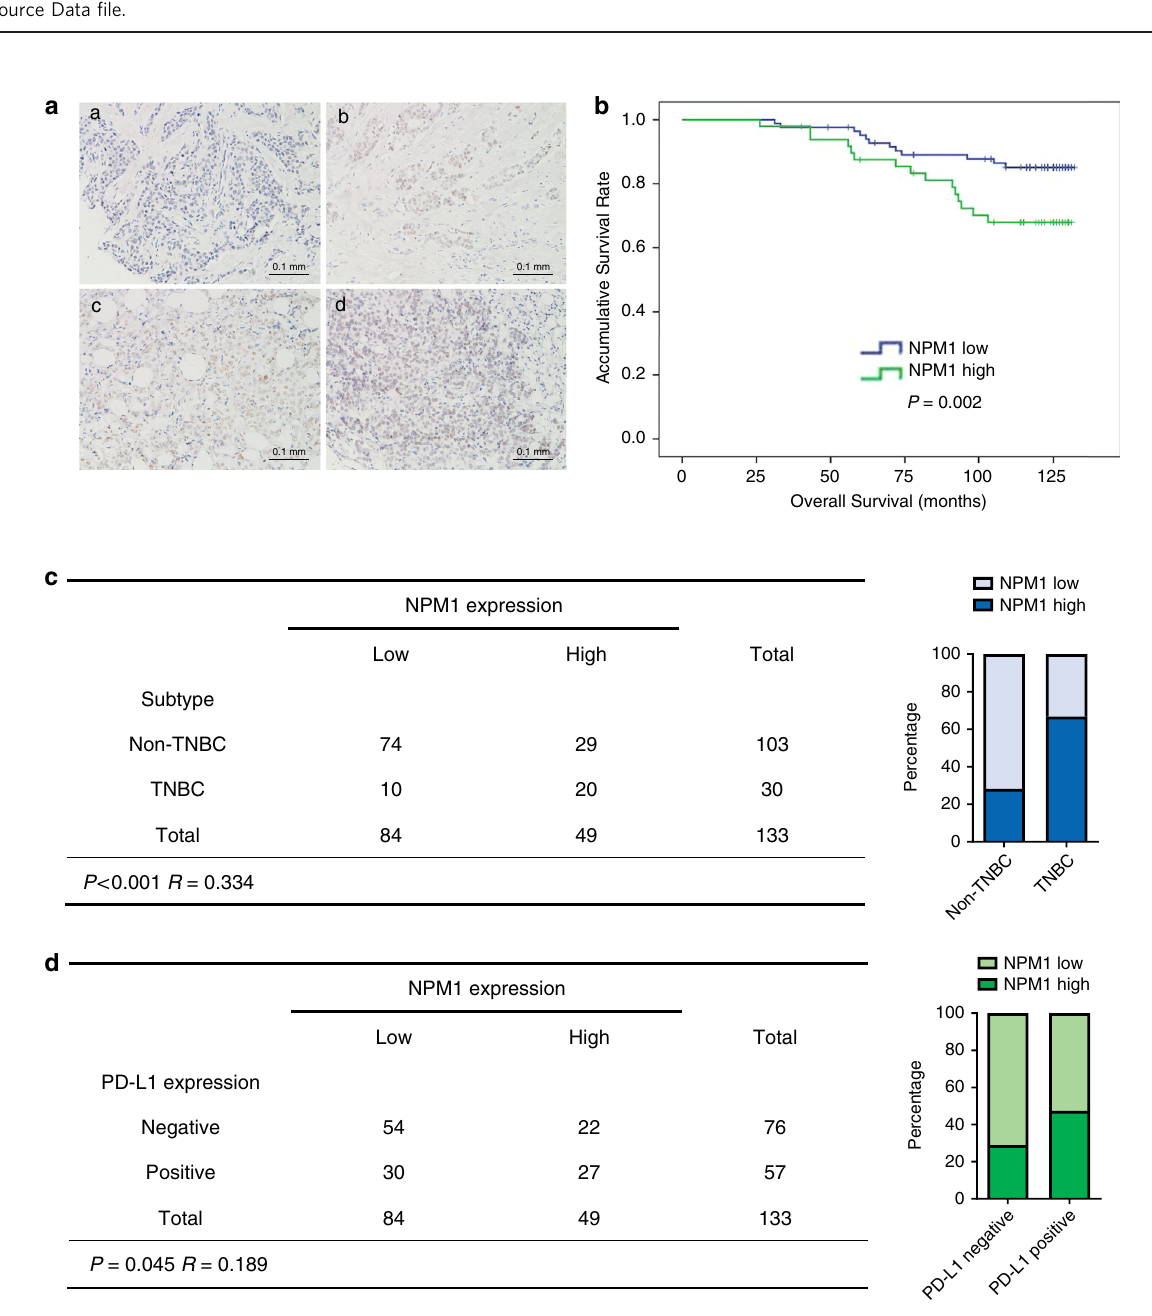
Fig. 3 Knockdown of NPM1 suppresses PD-L1 expression and promotes T cell activity in vivo. a 0.5 × 10 6 4T1 cells were injected into the mammary fat pads of BALB/c mice. The average tumor volume of each group was depicted over time. b The number of lung metastasis nodes of every mouse in each group ( n = 8) was graphed, and the metastasis rate in teach group was indicated above the bar. c Tumor in fi ltrating lymphocytes (TILs) in the tumors of each group ( n = 5) were analyzed by fl ow cytometry. d Granzyme B and CD8 in mouse tumor tissues of each group were detected by immuno fl uorescence (IF). Experiment was repeated in three animal samples with similar results. e NPM1 and PD-L1 expression was detected by IHC in mouse tumor tissues of each group. Experiment was repeated in three animal samples with similar results. Data were presented as mean ± s.d. of three independent experiments. a – c were analyzed by one-way ANOVA + two-side Tukey test. * P < 0.05, ** P < 0.01, ** * * P < 0.0001; ns, not signi fi cantly different. Source data are provided as a Source Data fi le.